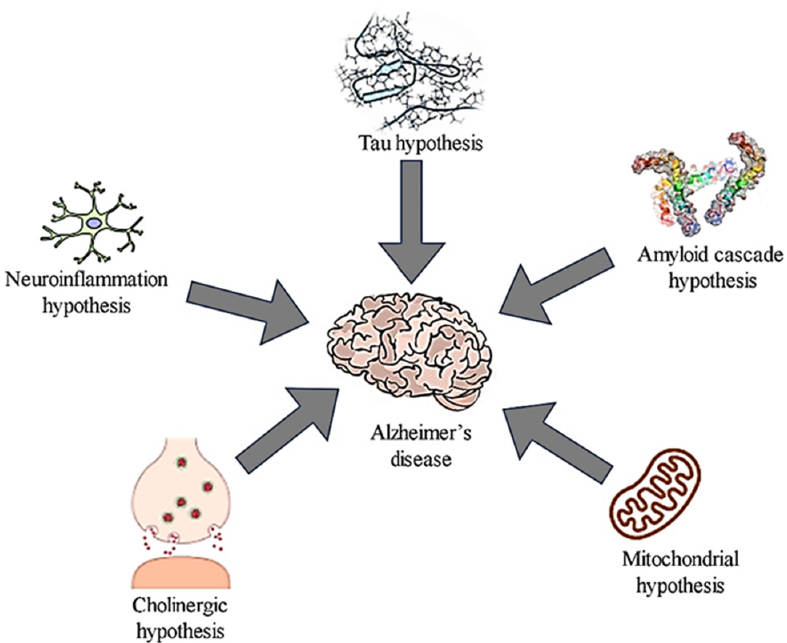
Figure 2. Proposed Alzheimer’s disease Hypothesis and the mechanisms involved [32]. “Reprinted